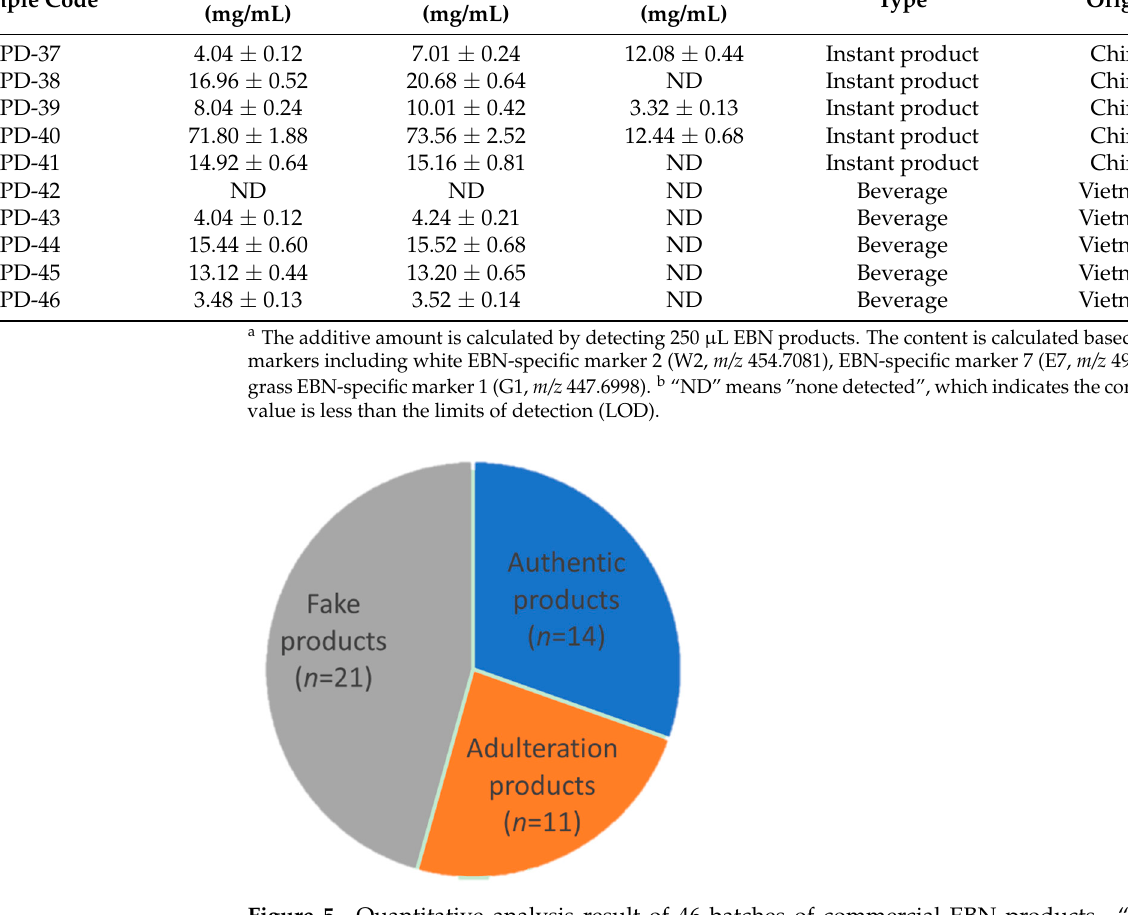
Figure 5. Quantitative analysis result of 46 batches of commercial EBN products. “Authentic products” indicates products which only contain white EBN, “Adulteration products” indicates products containing grass EBN, and “Fake products” indicates products which do not contain EBN.